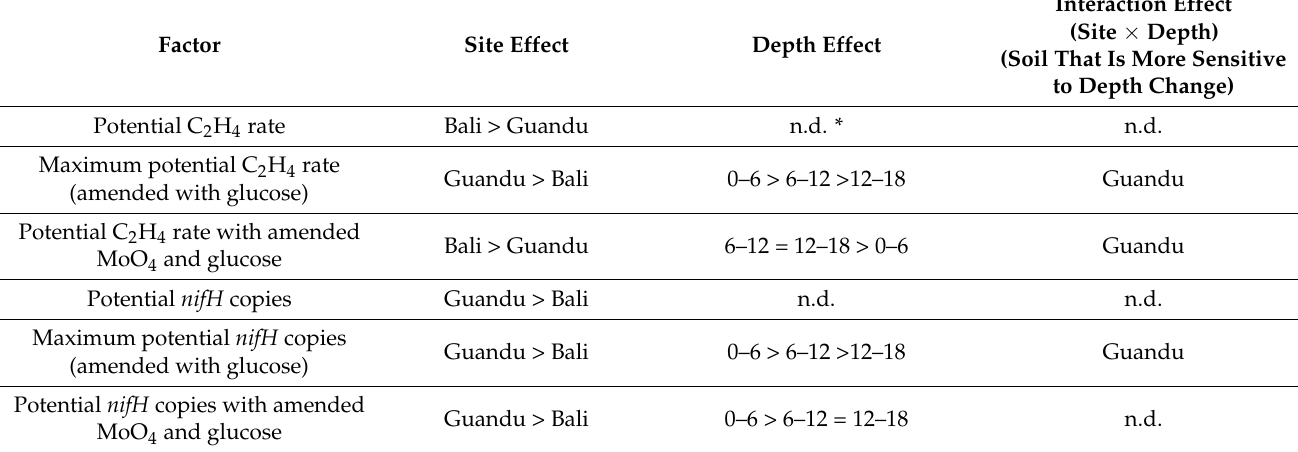
Table 1. Differences in soil nitrogenase activities and nifH copies for samples collected in the two mangrove forests, and three soil depths by two-way ANOVA, based on the significant level of 0.05 ( p < 0.05).